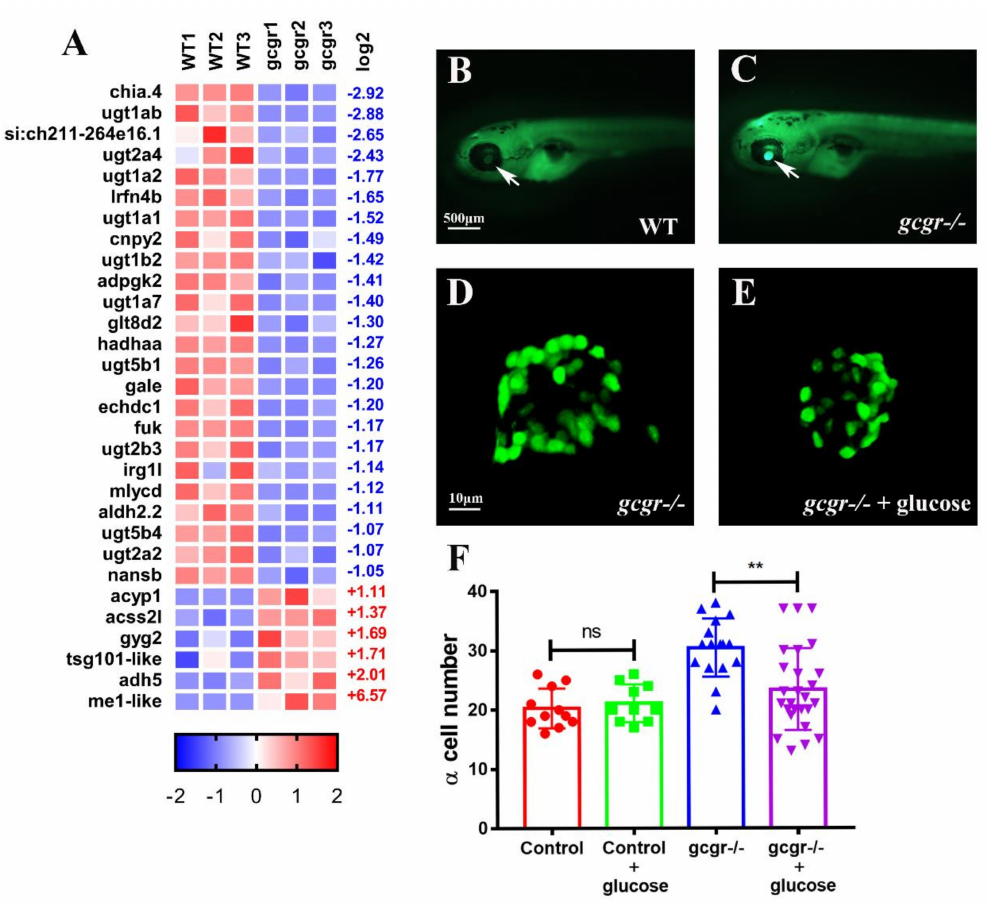
Figure 5. GCGR regulates carbohydrate metabolism in zebrafish larvae. ( A ) Heatmaps of transcripts in carbohydrate metabolism enrichment. Colors represent high (red), low (blue), or average (white) expression values based on the Z-score normalized FPKM values for each gene. The Z-score indicators are shown under each map. The fold change (log2) are shown on the right. ( B,C ) 2-NBDG glucose uptake of wildtype ( B ) and gcgr − / − mutant ( C ) larvae, the glucose uptake level is indicated by the fluorescence of lens (arrow) imaged by fluorescent microscopy. ( D–E ) Representative images of the principal islet of gcgr − / − ; Tg(gcga:GFP) ( D ) and 20 mM glucose treated- gcgr − / − ; Tg(gcga:GFP) ( E ). The images are confocal projections; scale bars indicate 10 µ m. ( F ) Quantification of the α -cell number in di ff erent groups of zebrafish at 7 dpf, n ≥ 10. Ns: No significance, and ** p < 0.01 by t